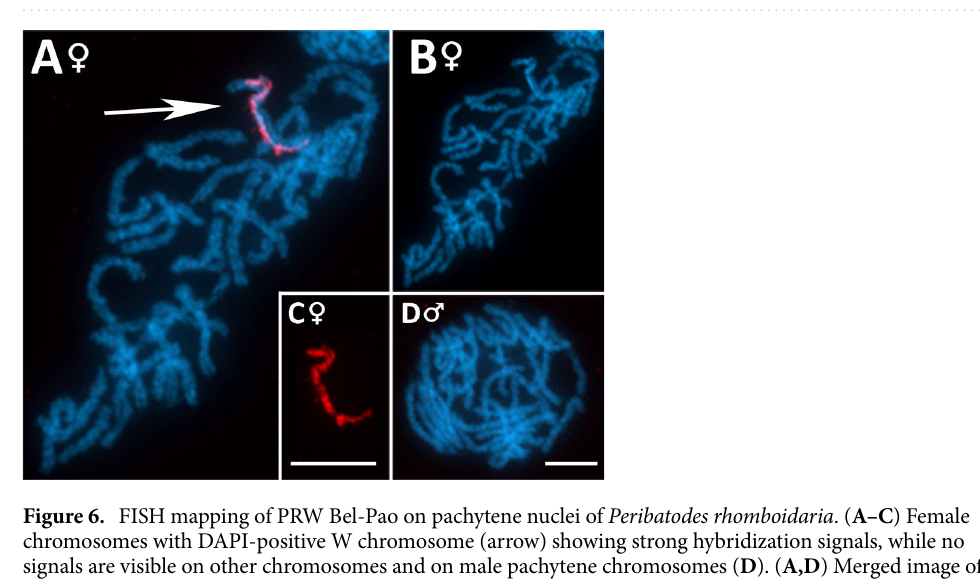
Figure 5. FISH mapping of PRW LINE-like on pachytene nuclei of Peribatodes rhomboidaria . ( A–C ) Female chromosomes with DAPI-positive W chromosome (arrow) accumulating hybridization signals and showing multiple scattered signals on other chromosomes, also seen in males ( D ). ( A,D ) Merged image of DAPI staining and probe (green), ( B ) DAPI staining, ( C ) probe (green). Bar = 10 μm.